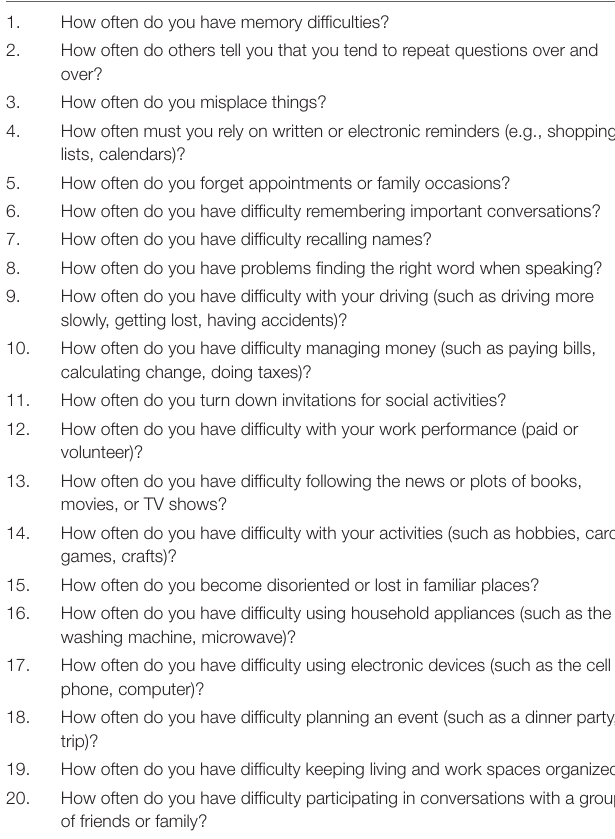
TABLE 2 | Current cognitive function instrument (CFI), participant